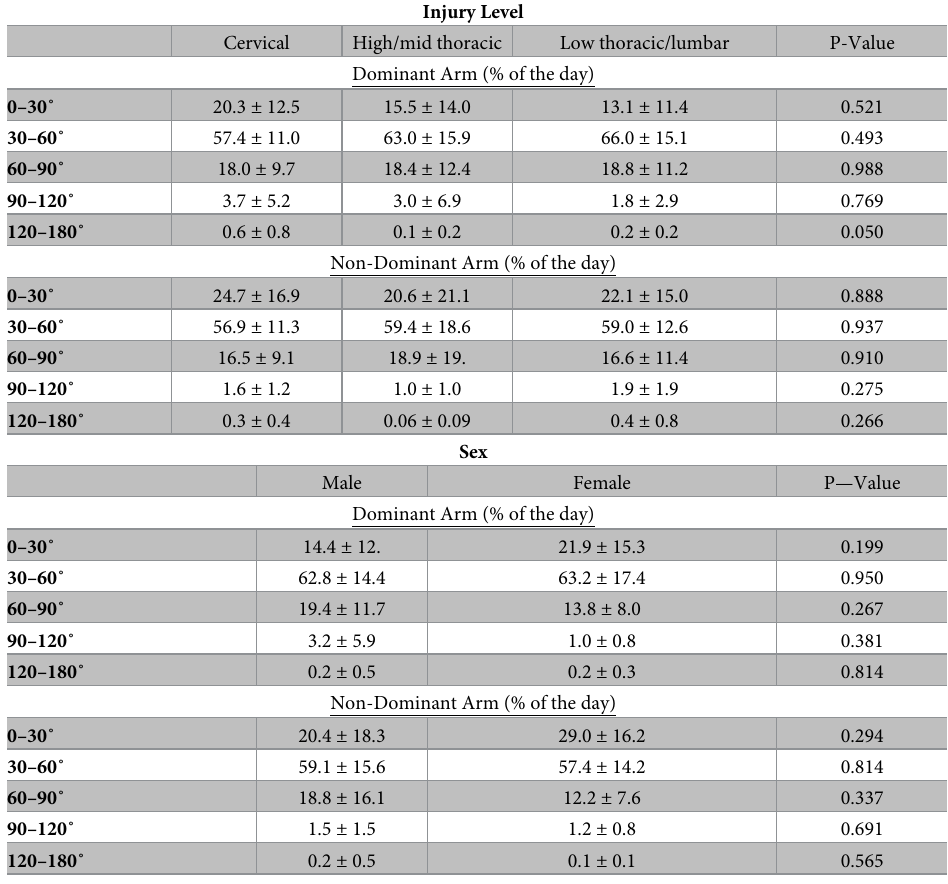
Table 3. The percentage of time individuals spent in humeral elevation bins based on their injury level and